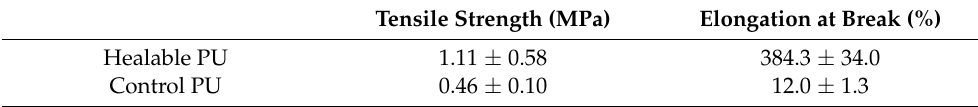
Table 2. Initial tensile strength and elongation of healable and control PU.